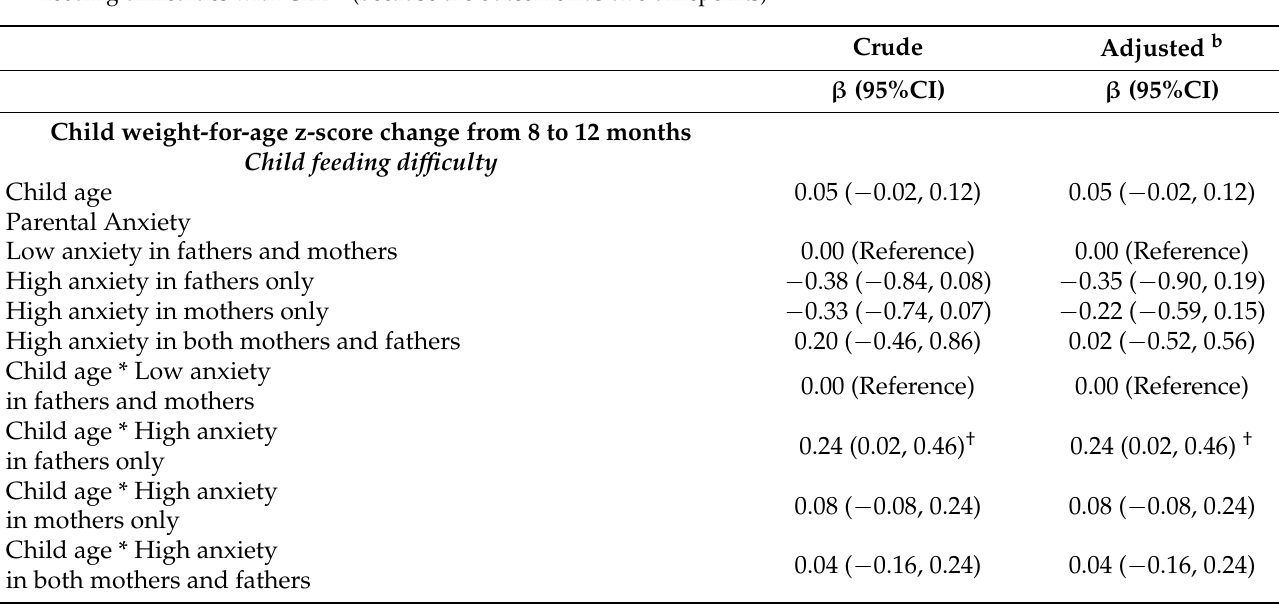
Table 3. Categorical profiles of paternal and maternal anxiety with change in child weight-for-age z-score from the second time point (median age of 8 months) to the third time point (median age of 12 months) in the imputed dataset, stratified by feeding difficulties with GEE a (because the outcome has two